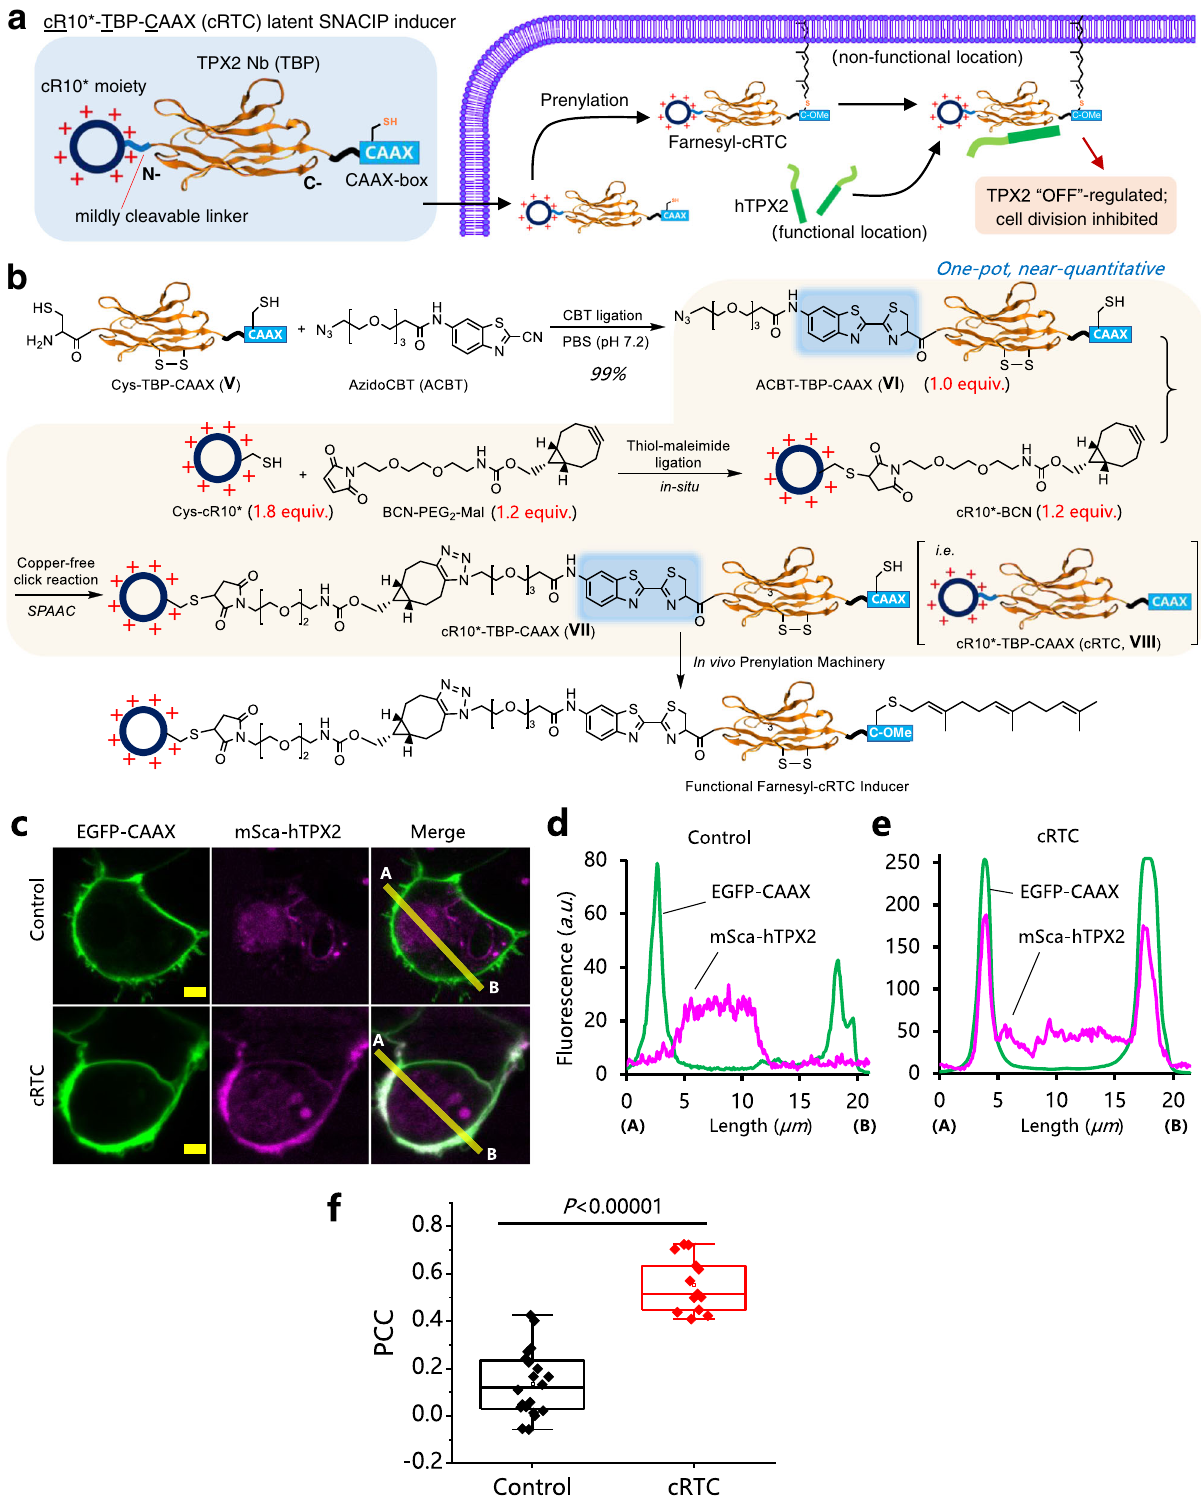
Fig.5|DesignofcRTCinduceranditsrapidassemblyviaN-terminalnanobody functionalization using stoichiometry-controlled one-pot tandem bioortho- gonal ligations. a Structural elements of cRTC (left) and schematic presentation of how cRTC “ OFF ” -regulates the key microtubule nucleation factor TPX2 (right). b Schematic view of the assembly of cRTC inducer (BCN: bicyclonornyne which reacts with azide via copper-free click reaction; Mal: maleimide which reacts with cysteine). c Live HepG2 cells coexpression of EGFP-CAAX (PM marker) and